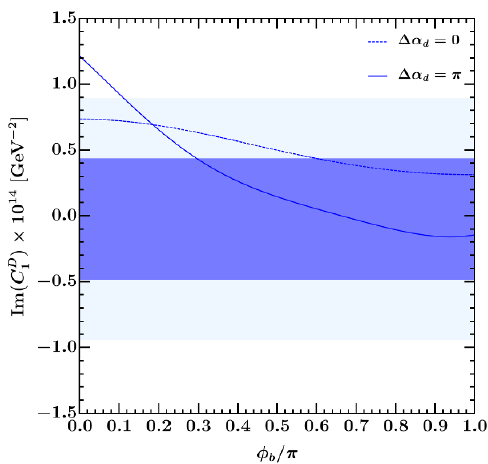
Figure 2 . Model contributions to Im( C D